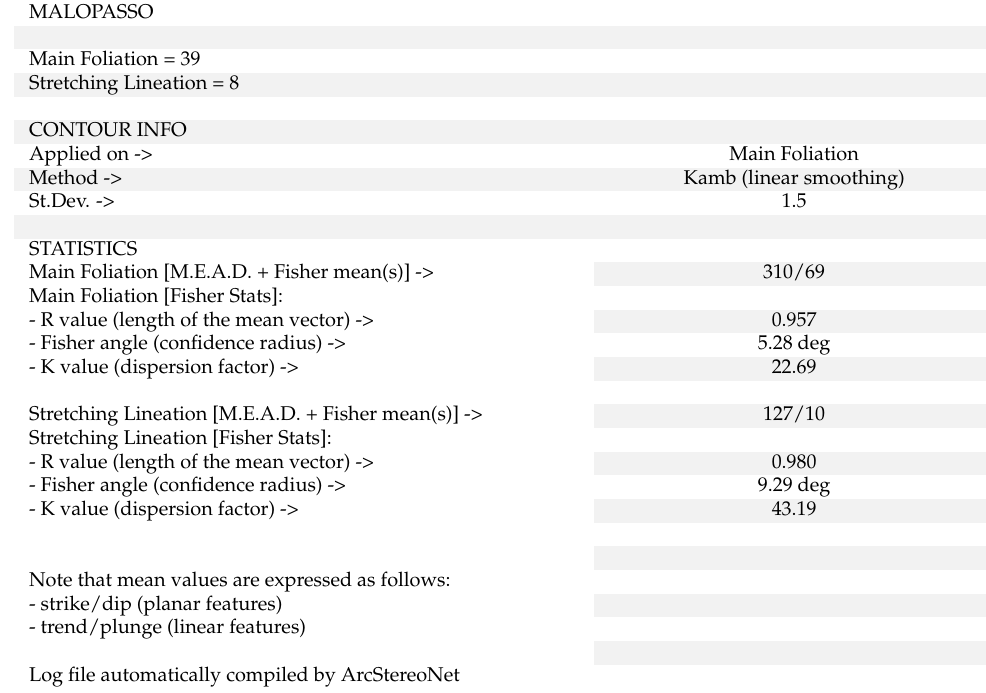
Table A6. ‘Malopasso’ station log file. The original .txt file has been converted to table